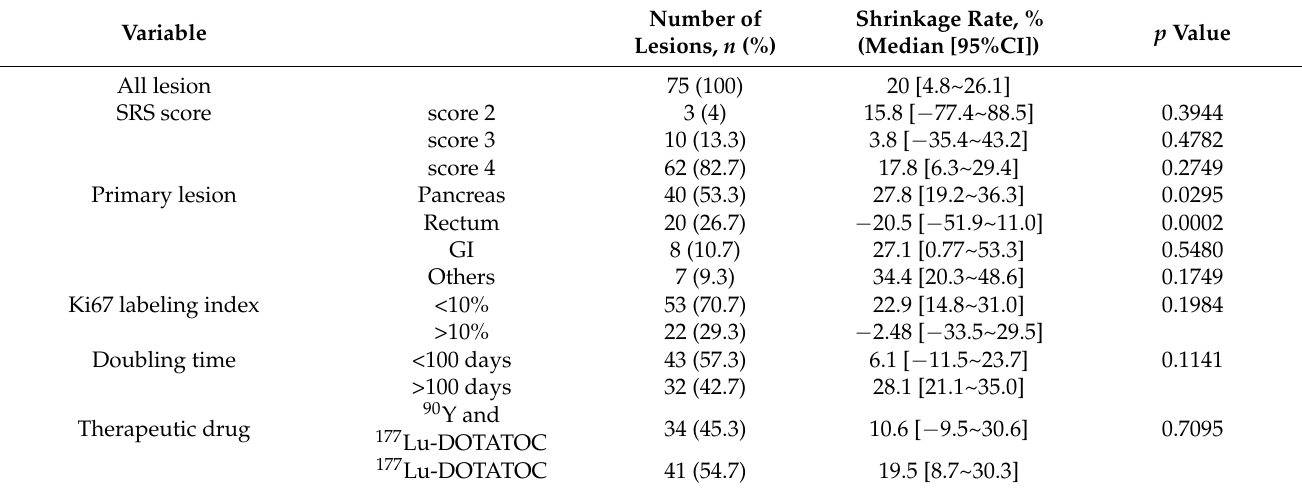
Table 2. Factors associated with tumor shrinkage in NET in lesion-based